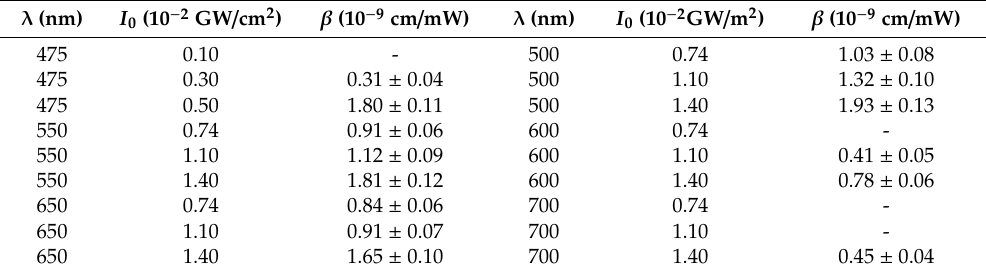
Figure 3. ( a ) The solid line shows the linear absorption spectra. The scatters are a theoretical fit of the nonlinear absorption coe ffi cient of the Ti 3 C 2 nanosheet as a function of wavelength. ( b ) A schematic diagram for reverse-saturable absorption processes. Table 1. Nonlinear optical parameters of the Ti 3 C 2